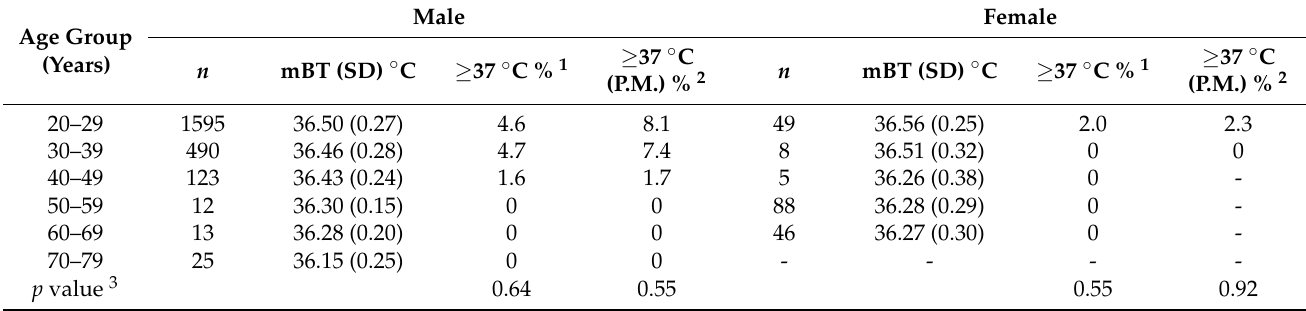
Table 2. Mean body temperature stratified by age and sex and the ratio of the subjects whose body temperature was 37 °C or higher.